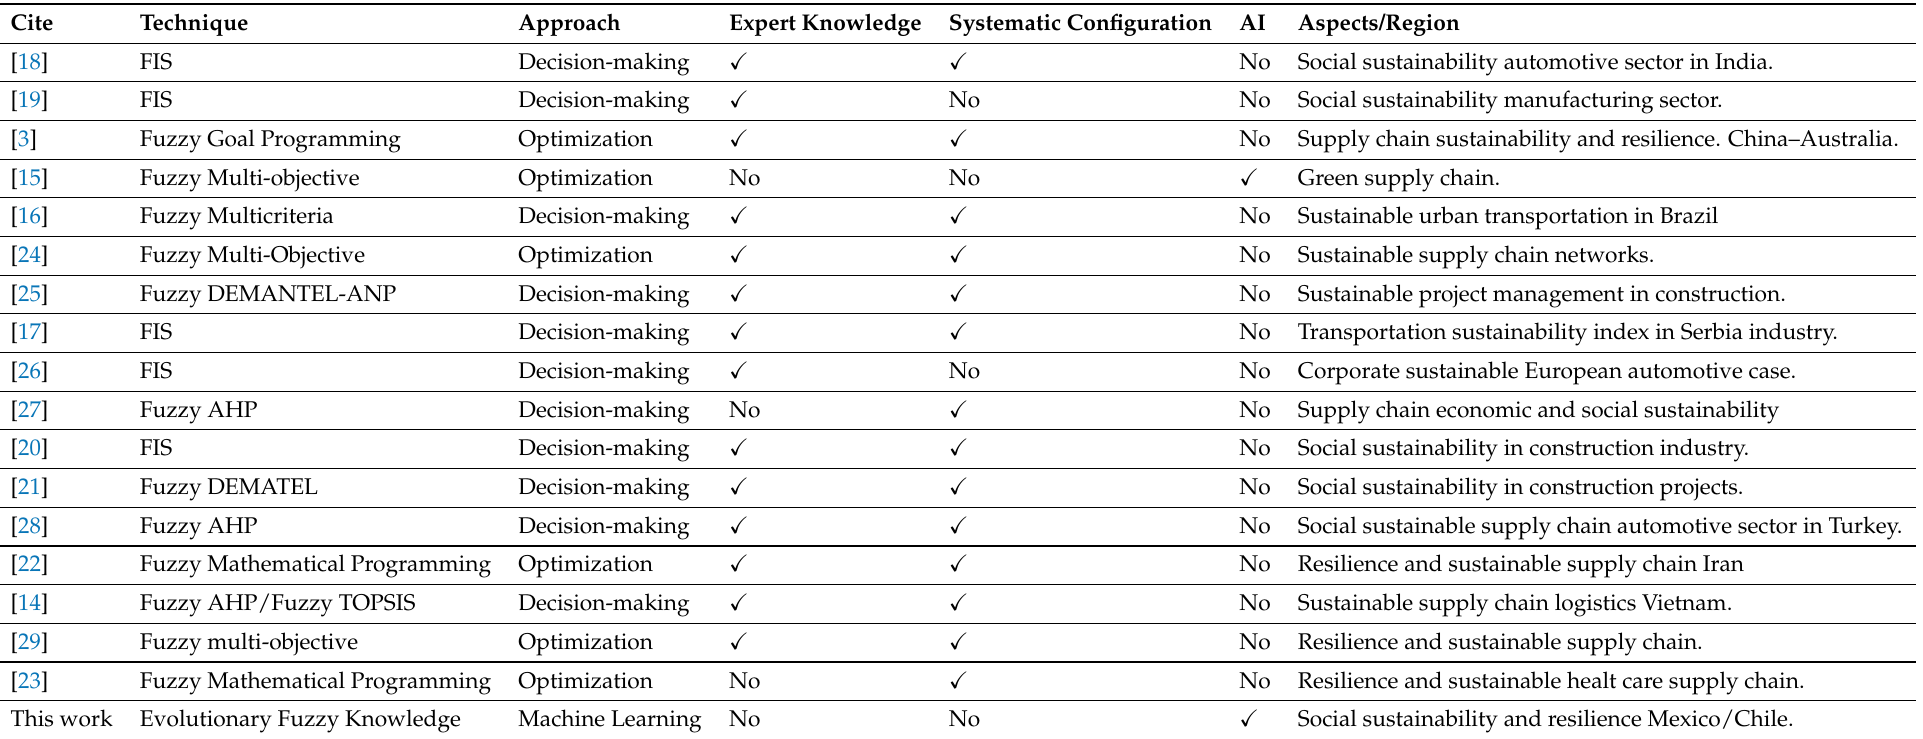
Table 1. Research on sustainability and its forms of discovering the fuzzy